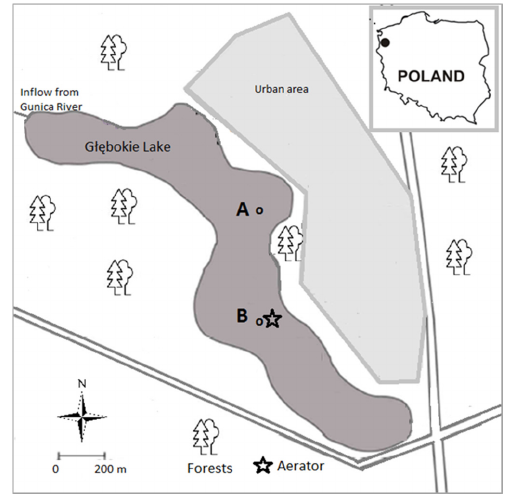
Figure 1. The location of sampling stations at Lake G łę bokie in Szczecin (city is marked in the map of Poland).